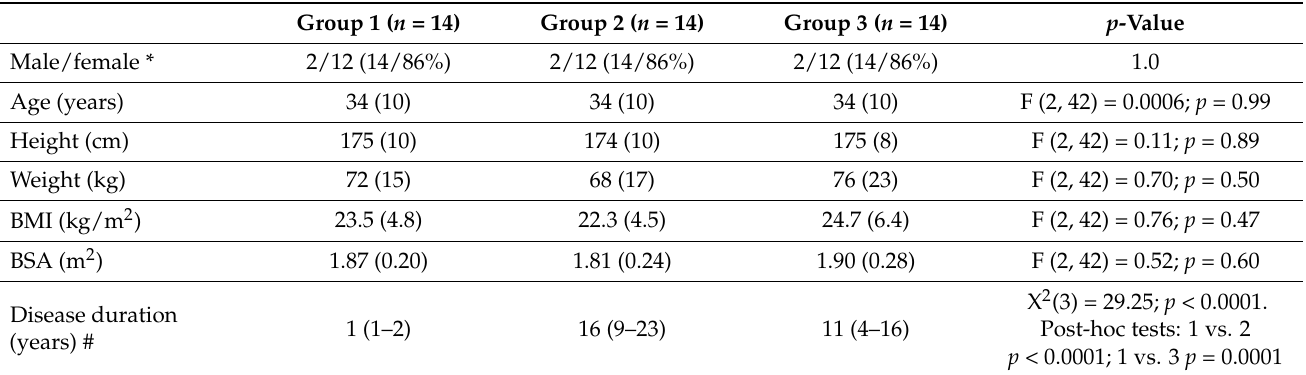
Table 1. Clinical characteristics of long-haul COVID patients (group 1), of ME/CFS patients with Ebstein Barr virus as a trigger (group 2) and of ME/CFS patients with an insidious onset of the disease (group